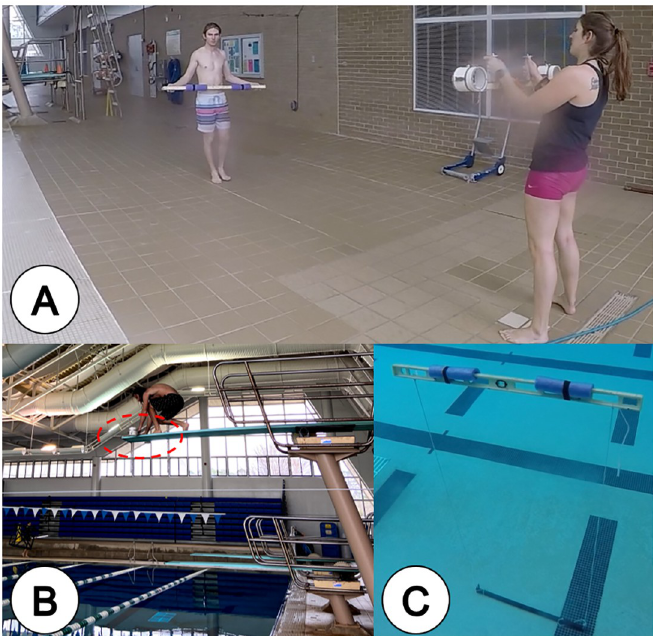
Fig 1. Examining the feasibility of using stereo-video footage collected from the air to measure objects below the water surface. (A) Calibrating the SeaGIS SVC to a custom scale bar before testing. (B) SeaGIS swimmable stereo- video camera on the high dive, stereo-video camera in red dashed outline. (C) Underwater scale bar testing mechanism at 5.0 m depth. Testing was conducted at the University of West Florida Aquatic